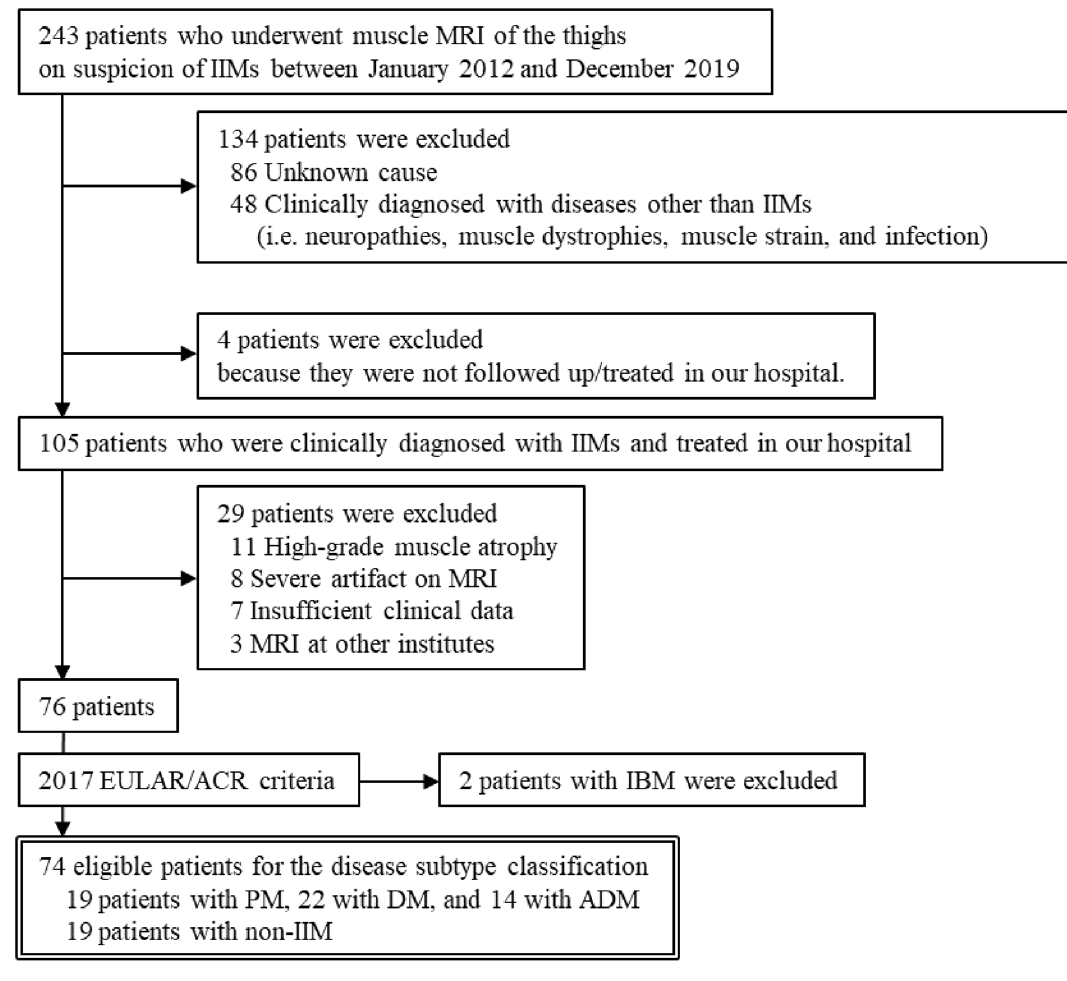
Figure 1. Flow chart of inclusion and exclusion